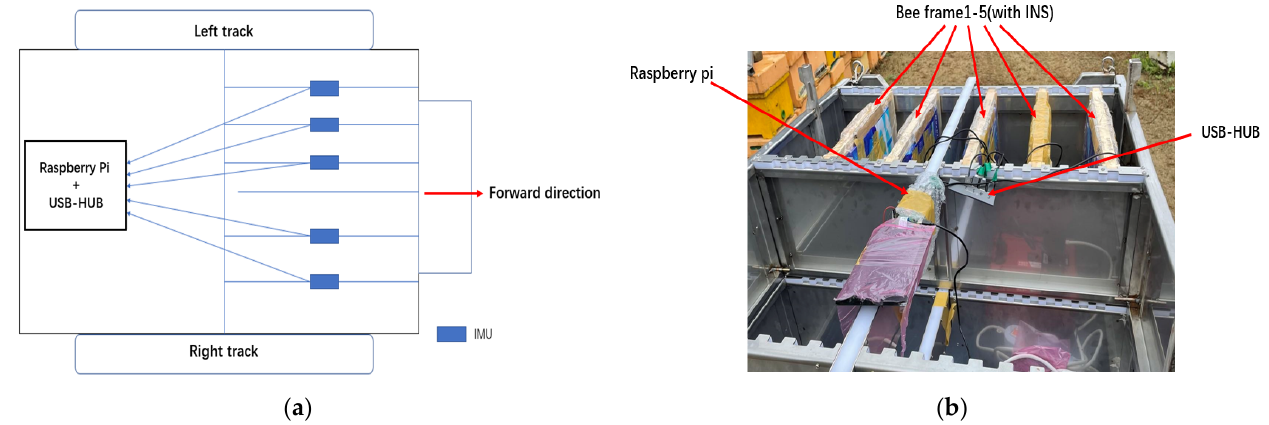
Figure 12. Experimental equipment: ( a ) conceptual diagram of experimental equipment and ( b ) actual experimental setup.